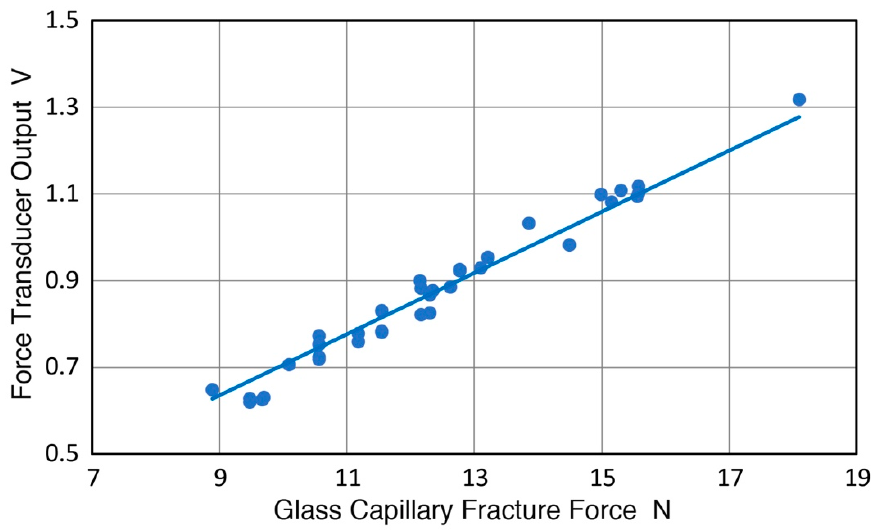
Figure 6. The output voltage from a force transducer (V112) vs. fracture force of GC tubes of 0.36 mm diameter.